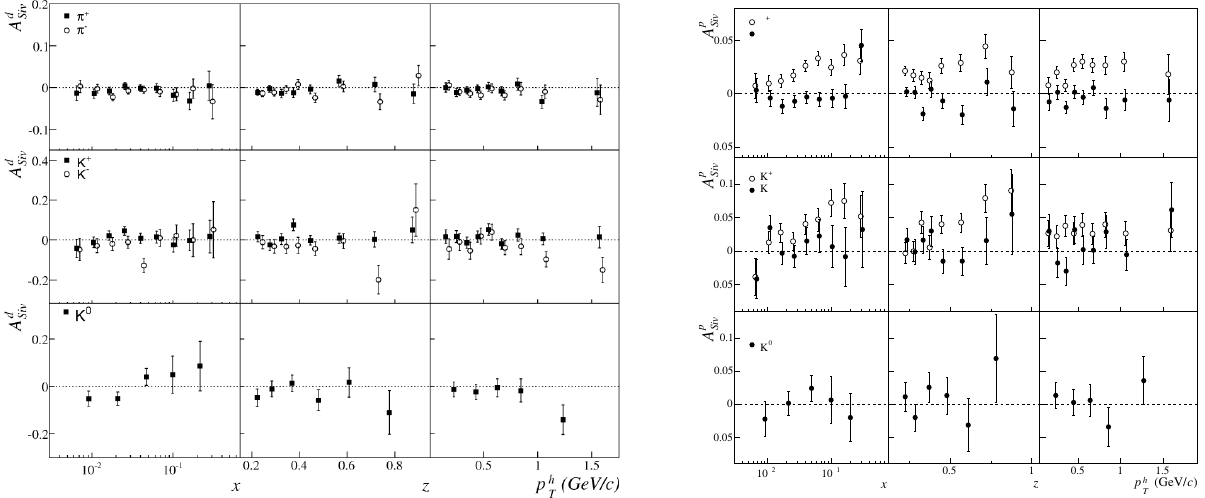
Figure 7. COMPASS measurements of the Sivers asymmetries for π ± and K ± , 0 on deuterons (left) and